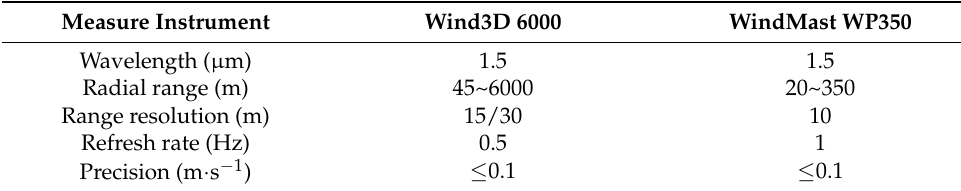
Table 2. Technical specifications of two